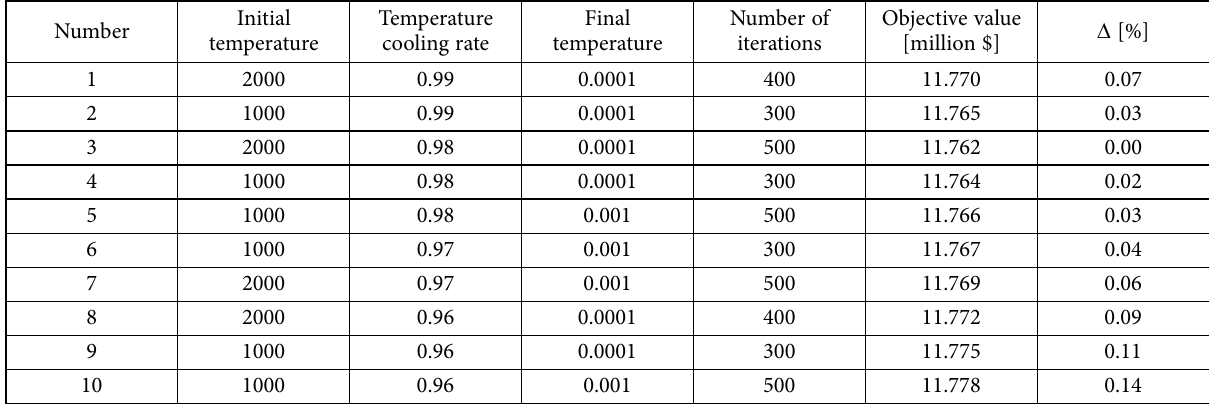
Table 3. Measuring robustness of the proposed